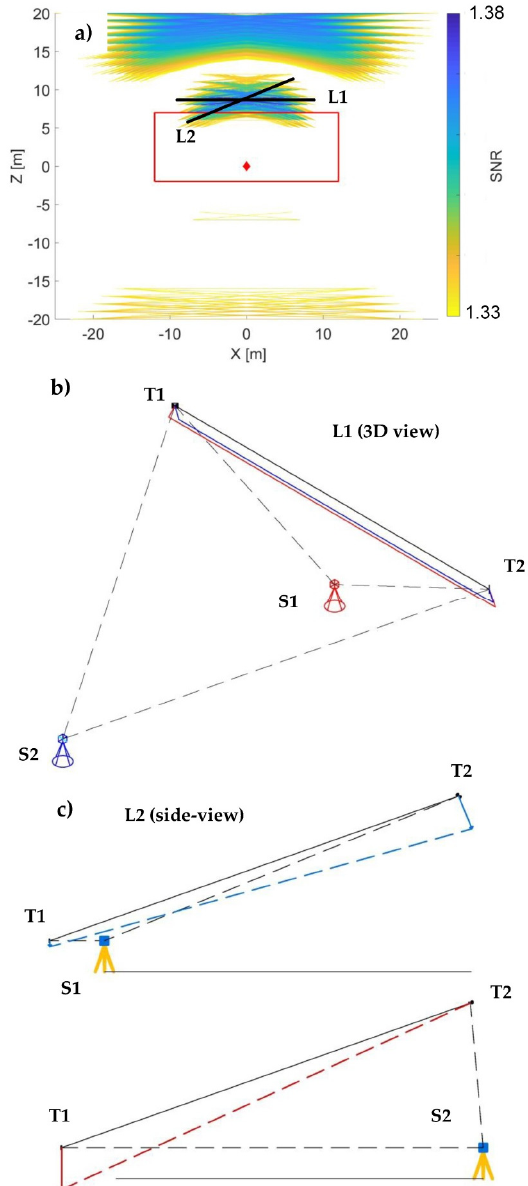
Figure 15. ( a ) The SNR ratio of the length consistency tests for x 5z (1% of the most sensitive measurement Figure 15 . (a) The SNR ratio of the length consistency tests for 𝑥 (cid:2873)(cid:2936) (1% of the most sensitive measurement configurations—colored lines, TLS—red rhombus, two most distinguishable configurations—colored lines, TLS—red rhombus, two most distinguishable length-tests—black lines length-tests—black lines L1 and L2). ( b,c ) 2 realizations of the length consistency test (both the most L1 and L2). ( b , c ) 2 realizations of the length consistency test (both the most and the least sensitive TLS and the least sensitive TLS positions) for 𝑥 (cid:2873)(cid:2936) ; red lines—length extension, blue lines—length positions) for x 5z ; red lines—length extension, blue lines—length translation or